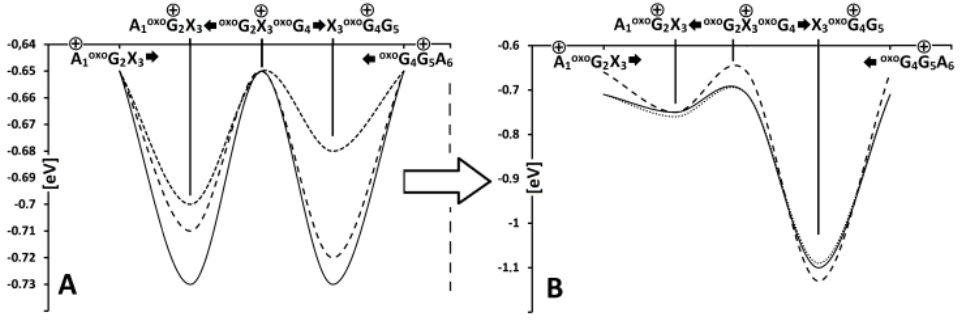
Figure 4. The energy barrier profile of the charge migration process through the double helix containing clustered lesions in vertical ( A ) and adiabatic ( B ) modes, as follows: --- A 1oxo G 2 A 3oxo G 4 G 5 A 6 ; clustered lesions in vertical ( A ) and adiabatic ( B ) modes, as follows: — A 1oxo G 2 A 3oxo G 4 G 5 A 6